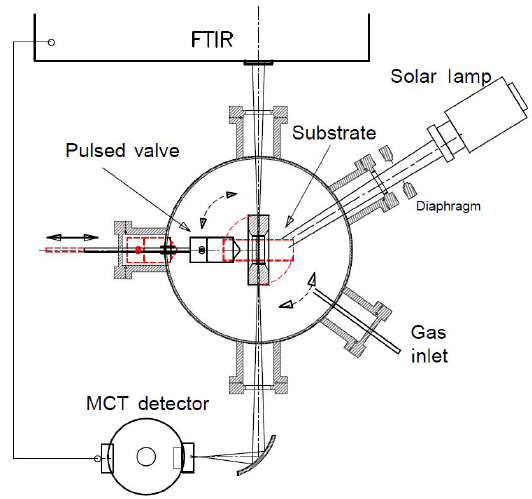
Figure 1. Schematic view of the experimental setup.